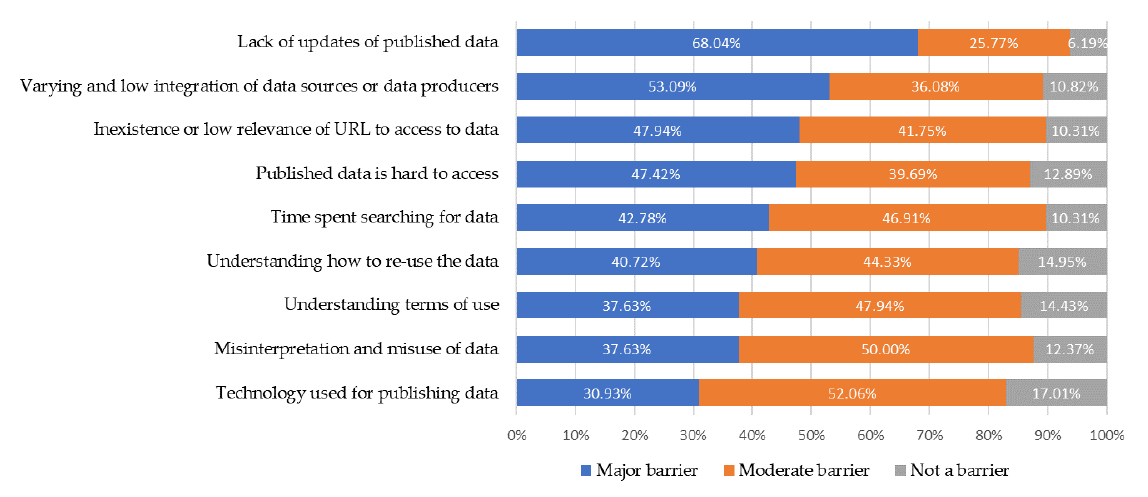
Figure 5. Barriers mentioned by respondents. Lack of updates of published data, varying and low integration of data sources, and low accessibility were considered to be major barriers ( n = 195).